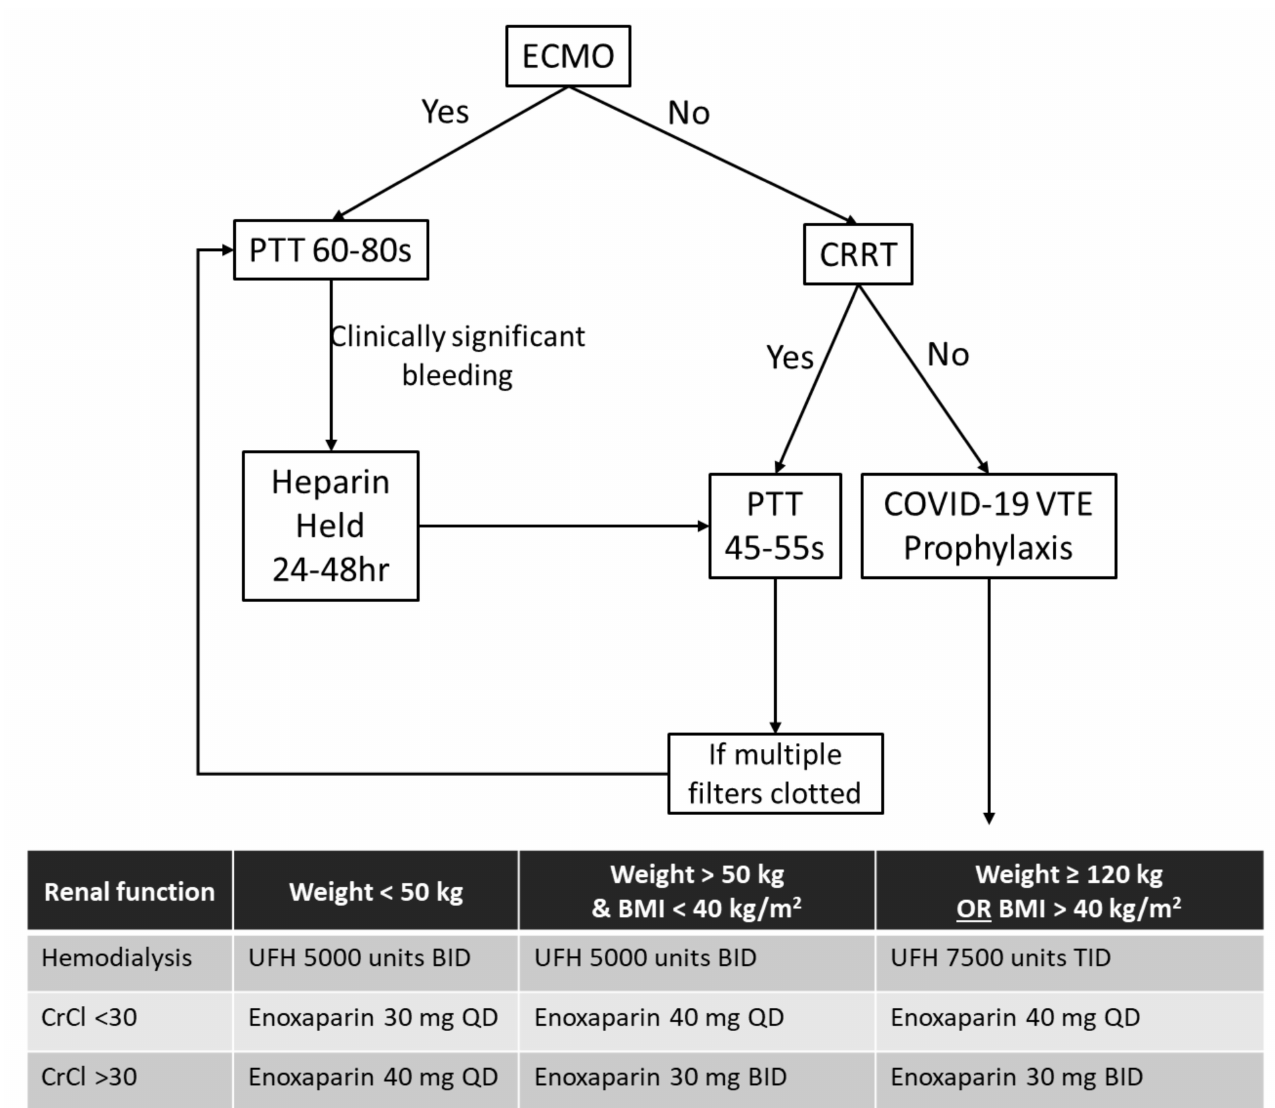
Figure 3. Anticoagulation algorithm for COVID-19 patients. Legend: BID—twice a day; CrCl—creatinine clearance; CRRT— continuous renal replacement therapy; ECMO—extracorporeal membrane oxygenation; PTT—partial thromboplastin time; QD—daily; TID—three times a day; and VTE—venous